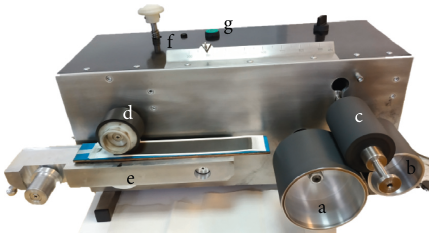
Figure 2: Laboratory paint tester.